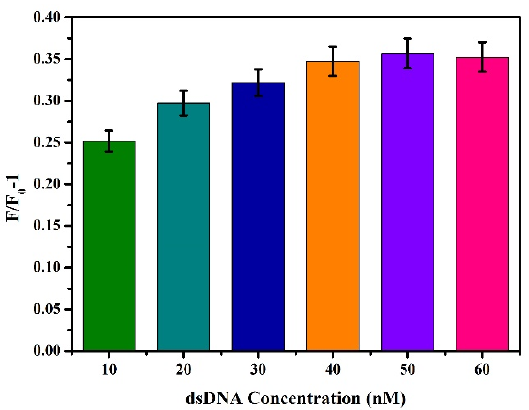
Figure 4. Effects of different concentrations of dsDNA on fluorescence intensity.